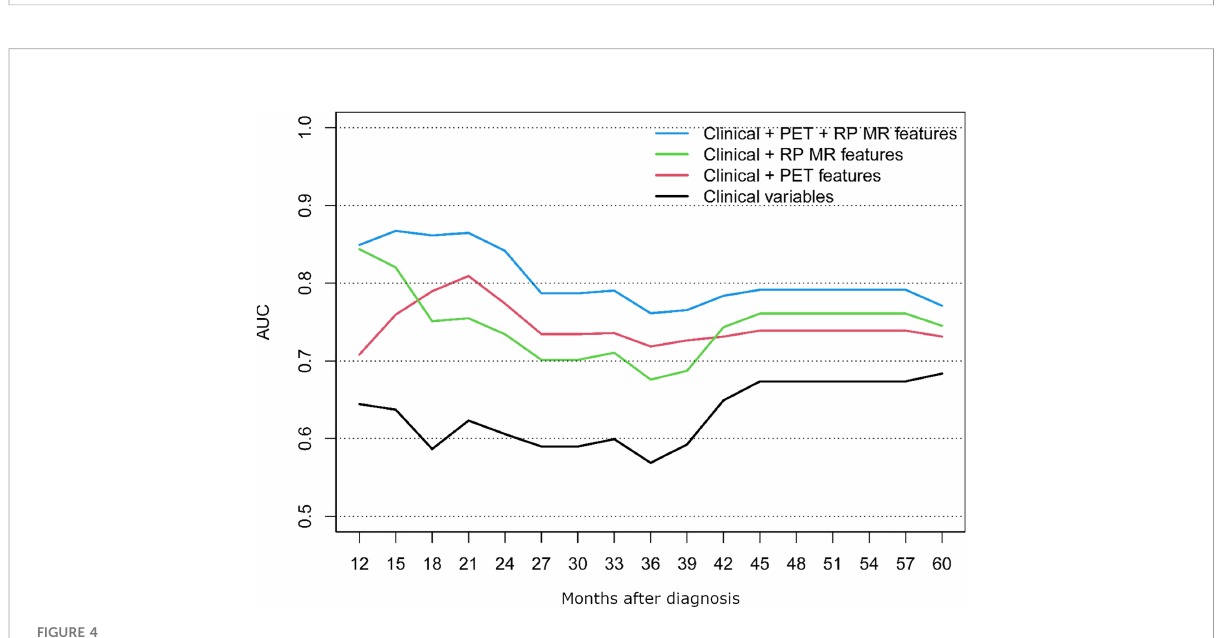
FIGURE 4 PFS AUC comparison between the different prognostic